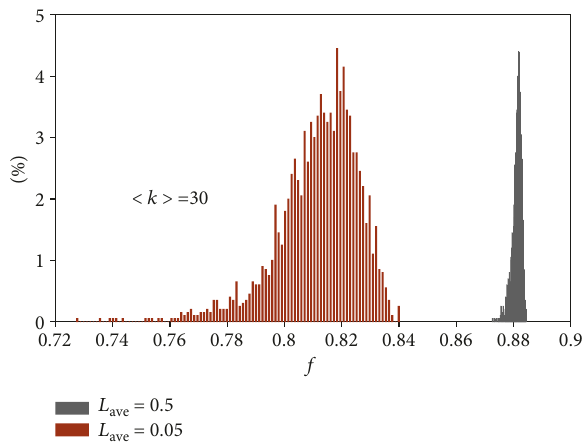
Figure 5: The evolution of credit risk contagion under two di ff erent average connection weights when < k > = 30 .